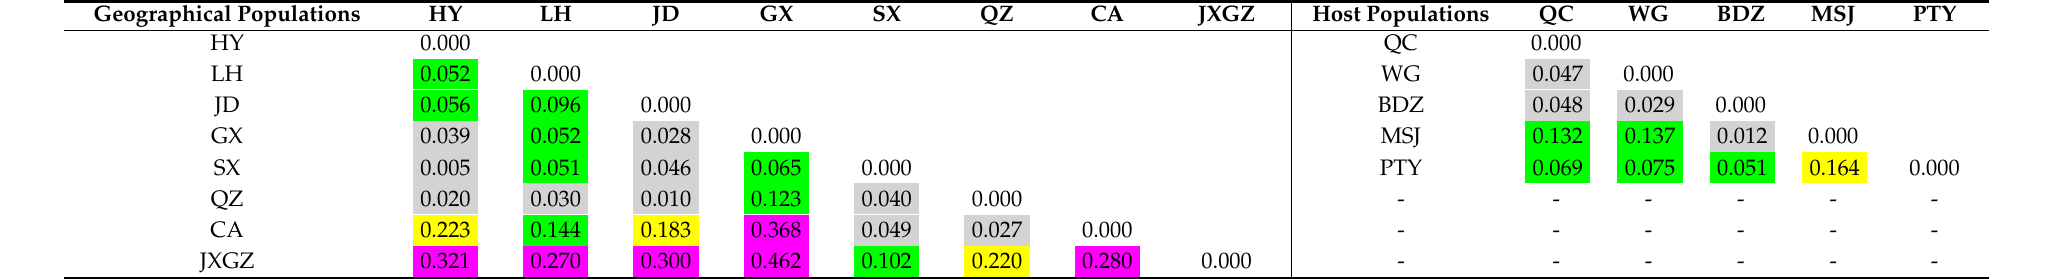
Table 3. Pairwise Fst values between the geographical populations and host populations of Colletotrichum gloeosporioides from Citrus in China.